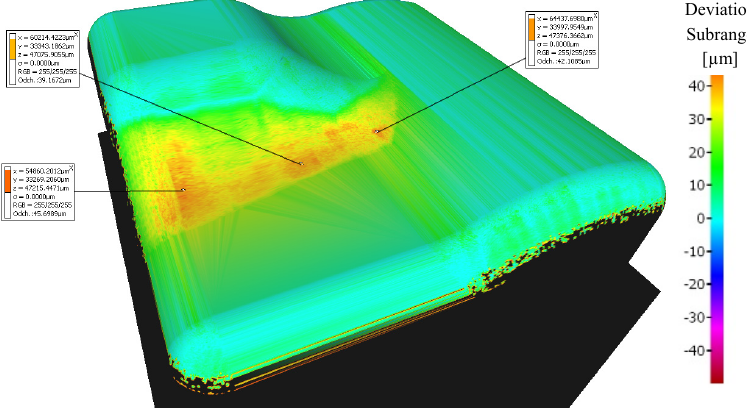
Figure 10. Comparison of the initial model with the workpiece after 3-axis milling (without tool axis inclination: β f = 0°, β n = 0°).